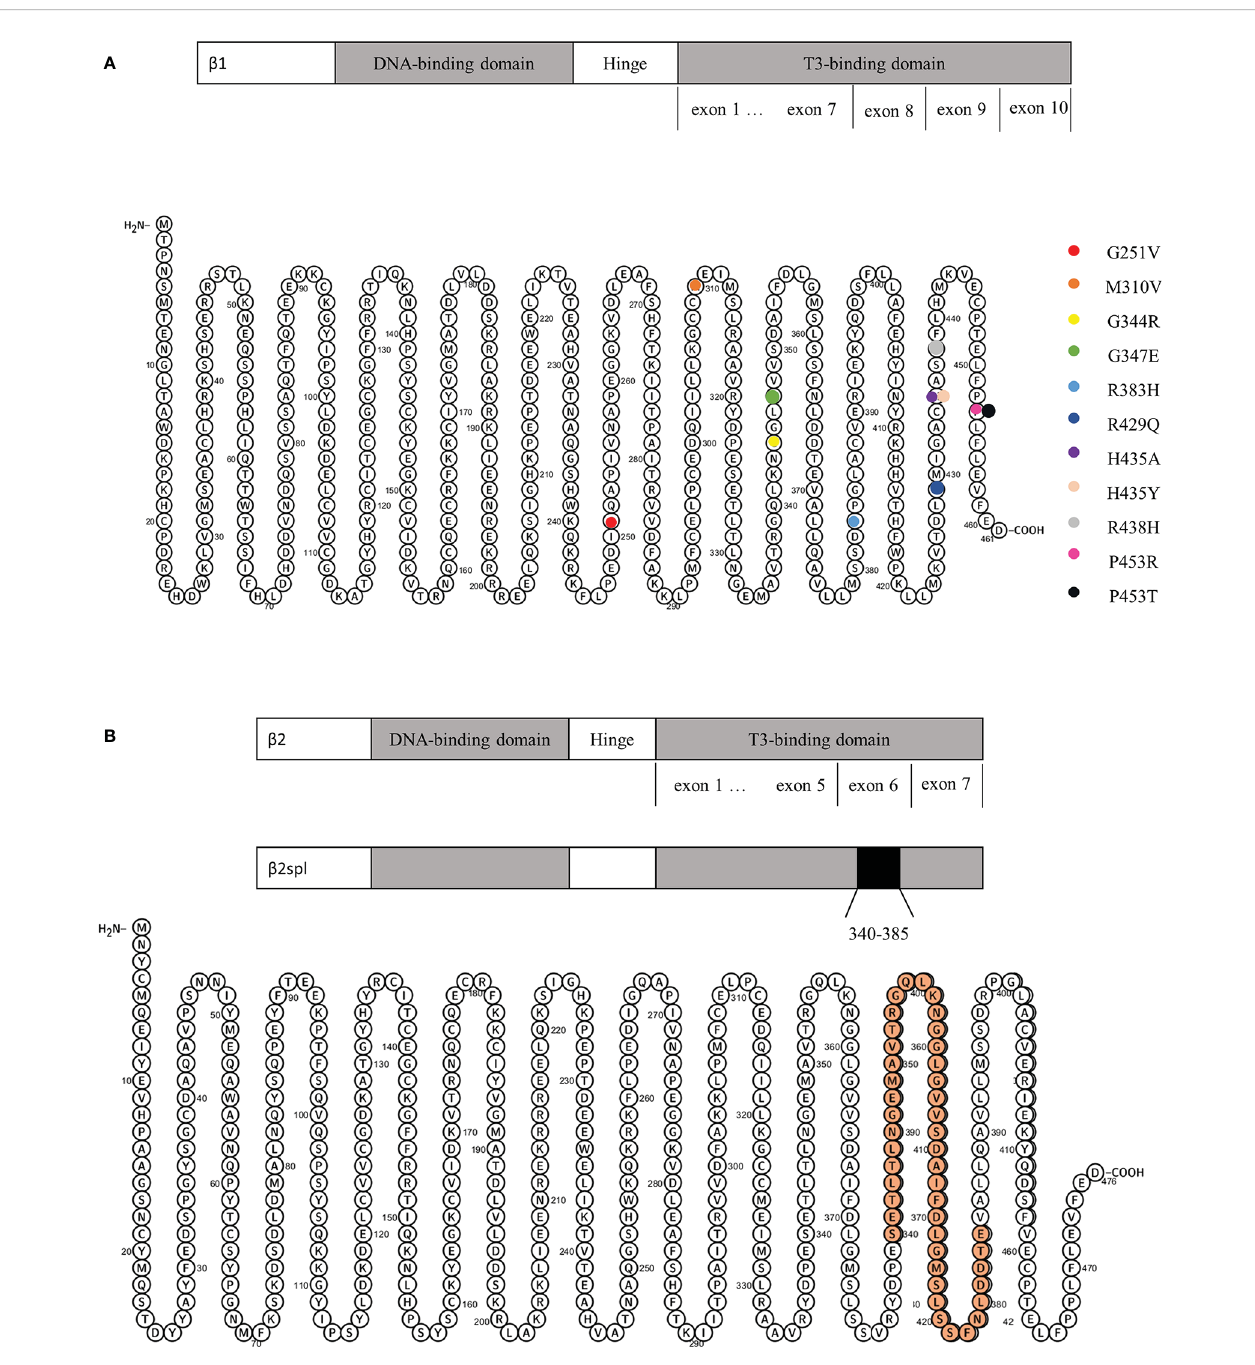
FIGURE 4 (A) Schematic representation of THR b 1 and its gene mutations. (B) Schematic representation of THR b 2 and its deletion from amino acids 340 to